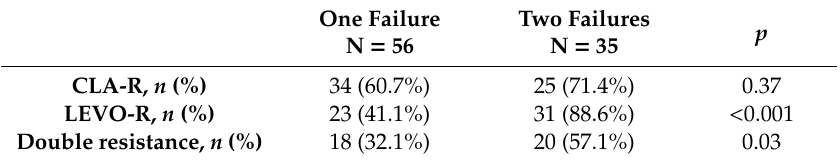
Table 2. Comparison of antibiotic resistance between patients with one or two therapy failures.